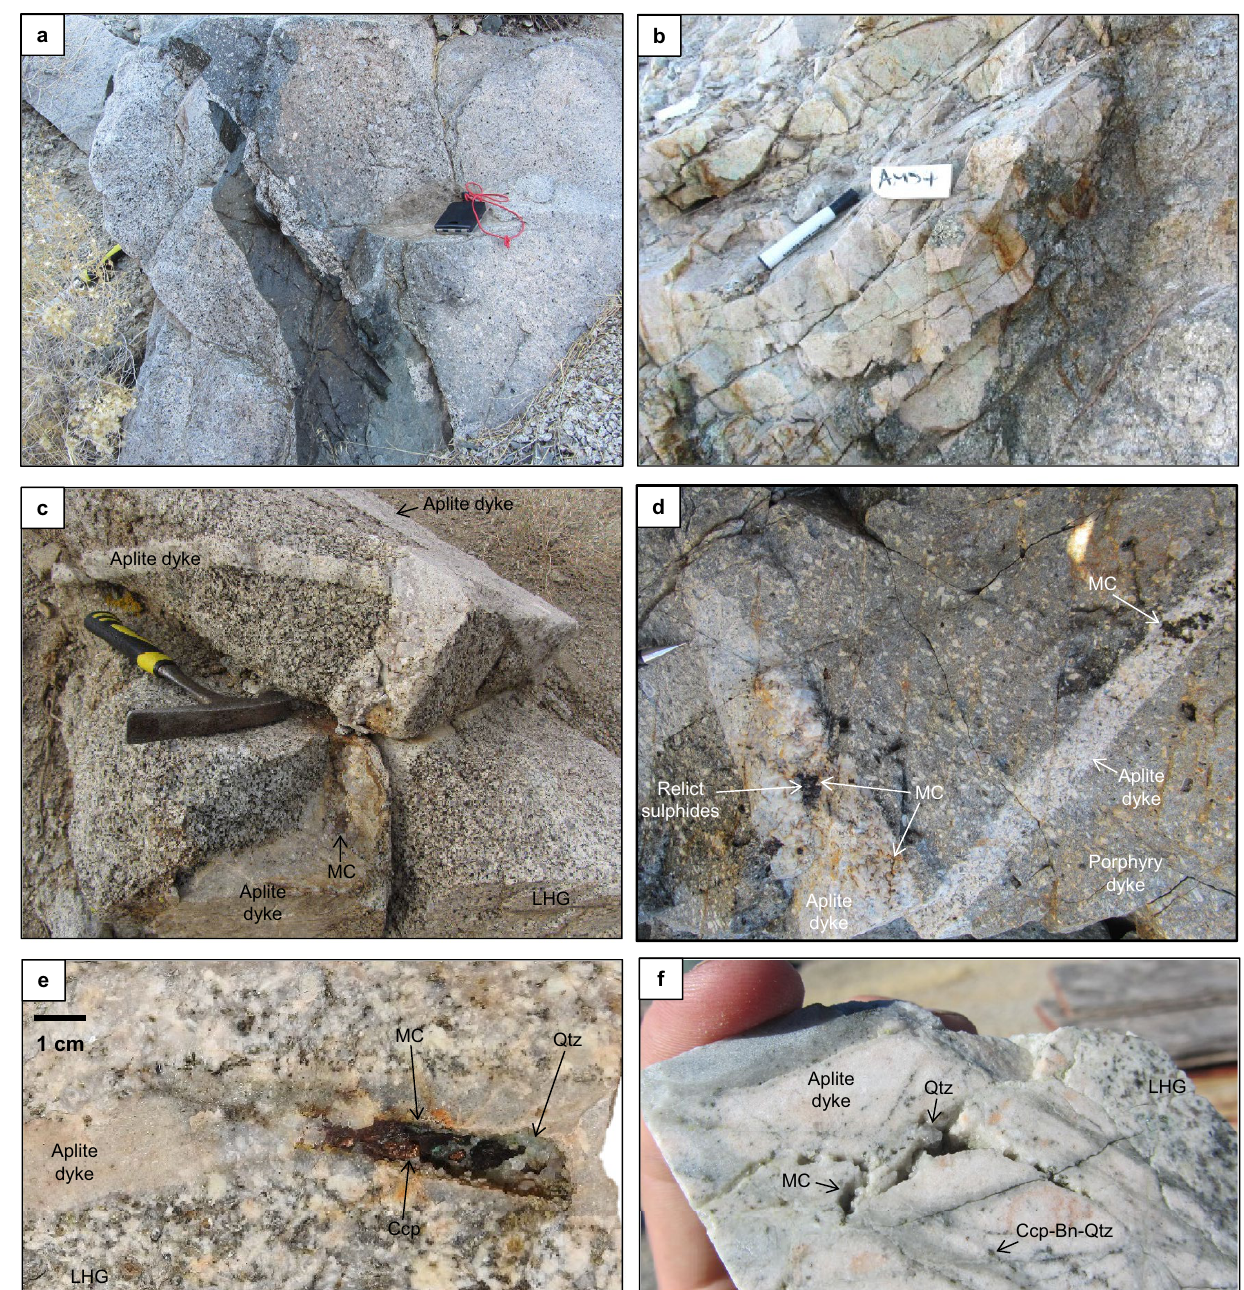
Figure 3. Temporal relations in the Yerington magmatic system: Field photographs of; ( a ) cross-cutting relations of multiple porphyry dyke generations which cut the LHG cupola; ( b ) lobate contacts and evidence for mingling of co-eval magmas between an aplite dyke and porphyry dyke. Secondary copper staining prevalent in the aplite dyke; ( c, d) multiple generations of aplite dykes hosting pegmatitic segregations and mineralised miarolitic cavities (MC). The aplite dykes sharply cross-cut the cupola zone of the LHG and a porphyry dyke. Both the aplite and porphyry dykes lie palaeo-vertically beneath the Ann Mason porphyry deposit; ( e ) cupola zone of LHG cut by an aplite dyke hosting a chalcopyrite (Ccp) mineralised miarolitic cavity. This aplite dyke is sample AM13BAP in Fig. 4. Qtz = quartz; ( f ) drill core from the Ann Mason porphyry deposit showing LHG cut by an aplite dyke hosting miarolitic cavities and early chalcopyrite-bornite-quartz (Ccp-Bn-Qtz) (‘A-type’, nomenclature after 51 ) veins, which locally truncate at the dyke’s margin. ( e, f ) from 33